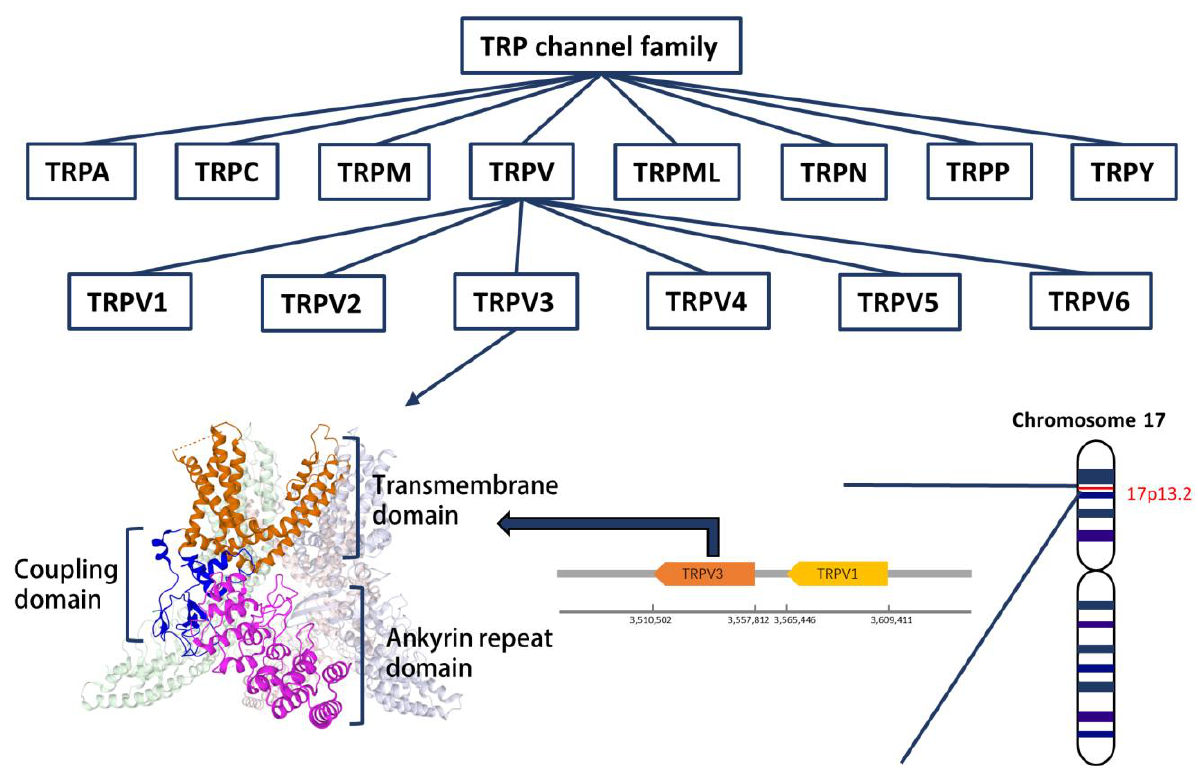
Figure 1. TRP channel family and TRPV3 channel protein. TRP channel, transient receptor potential cation channel. TRPA, TRP channel subfamily A (ankyrin). TRPC, TRP channel subfamily C (canon- ical). TRPM, TRP channel subfamily M (melastatin). TRPML, TRP channel (mucolipin). TRPN, TRP